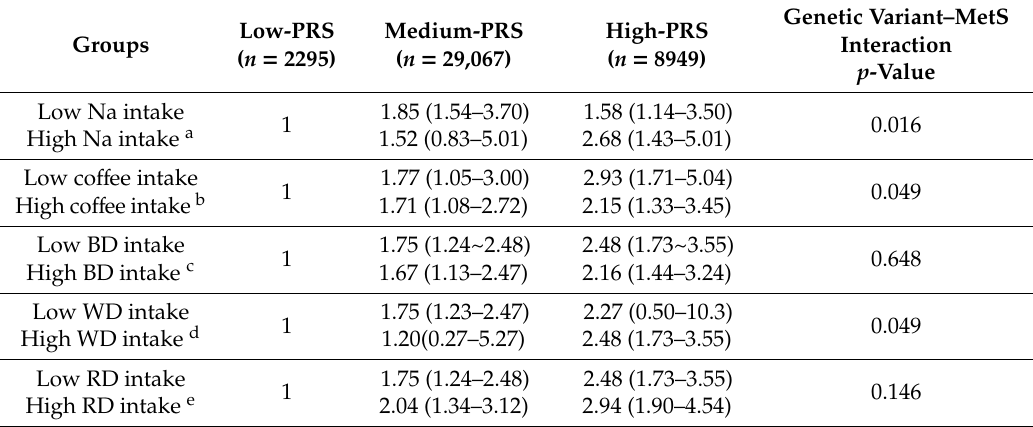
Table 5. Adjusted odds ratios for the age-related cataract risk by polygenetic risk scores of the best model (PRS) in the gene–diet interactions after covariate adjustments.